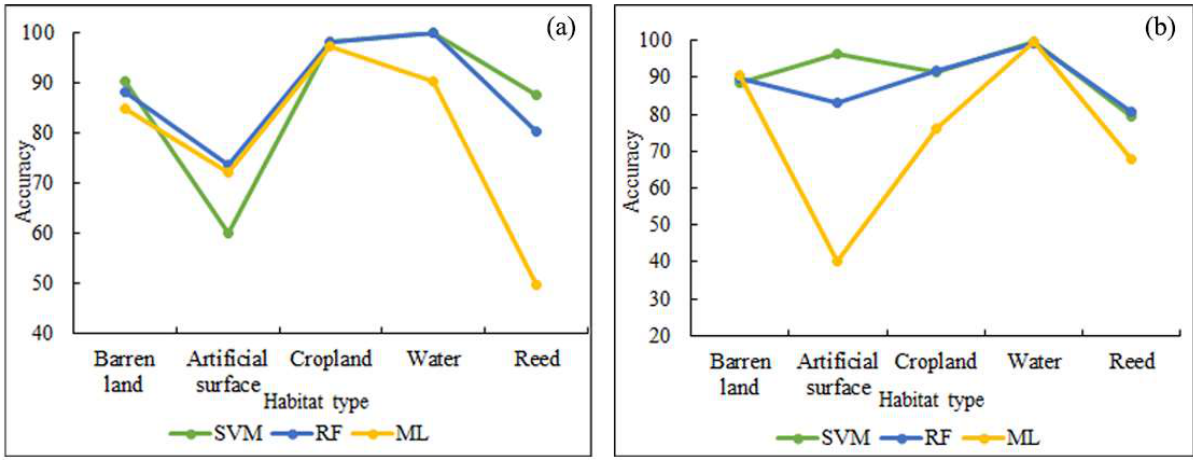
Figure 4. Classification accuracy for the single habitat of the three methods. ( a ) PA; ( b ) UA.